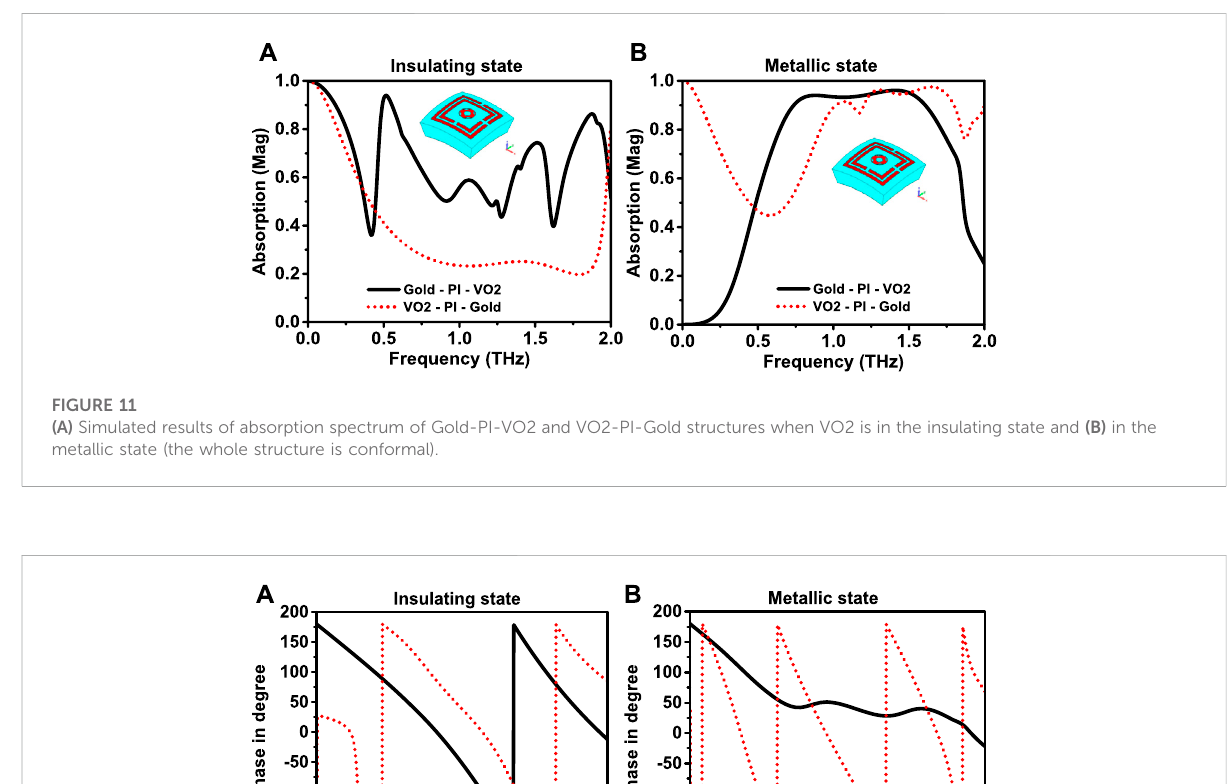
FIGURE 12 Simulated results of the phase degree for VO2 in the (A) insulating state and (B) metallic state.